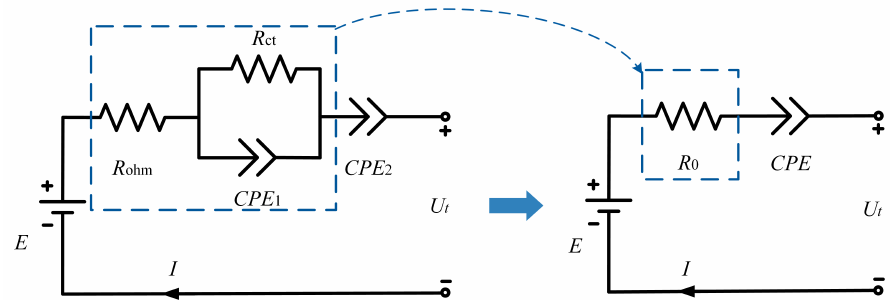
Figure 5. Simplifie FOM of LIBs as fractional-order PDE